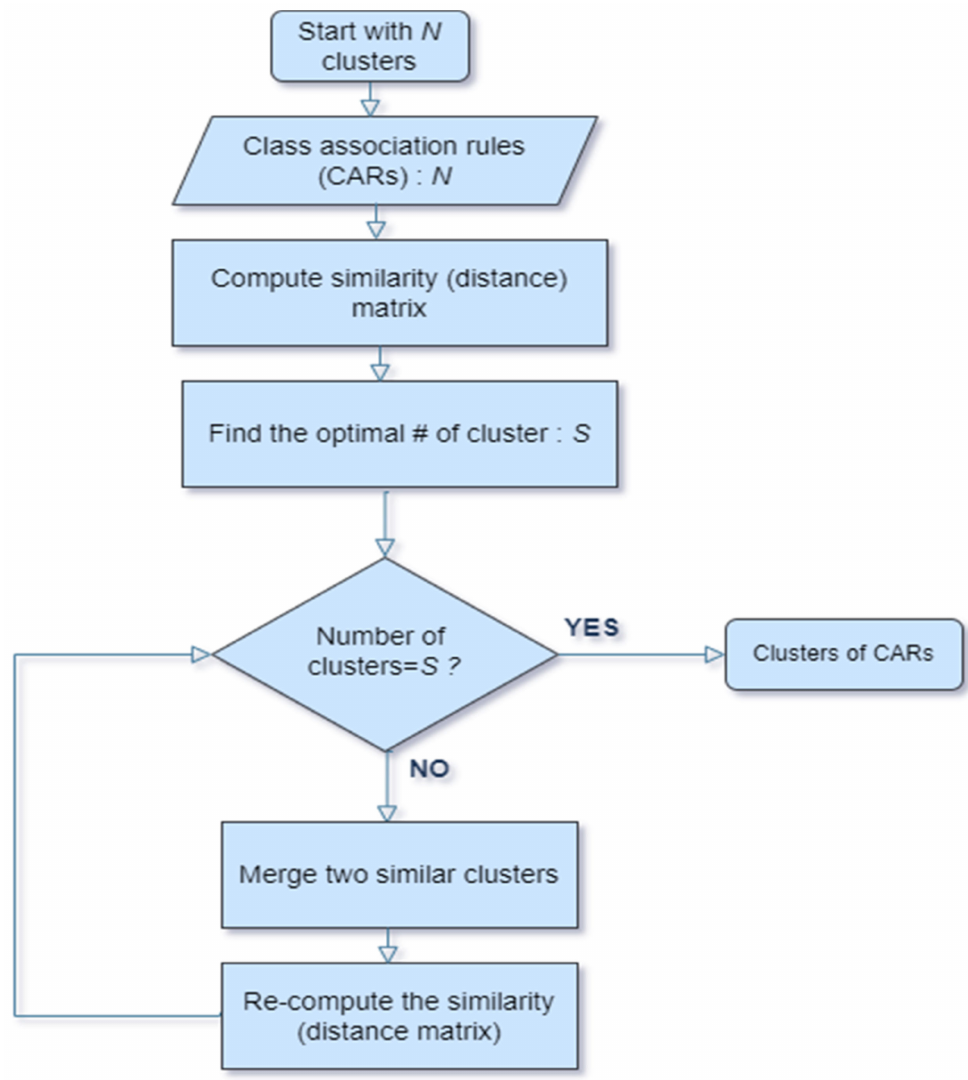
Figure 2. Clustering phase of our developed